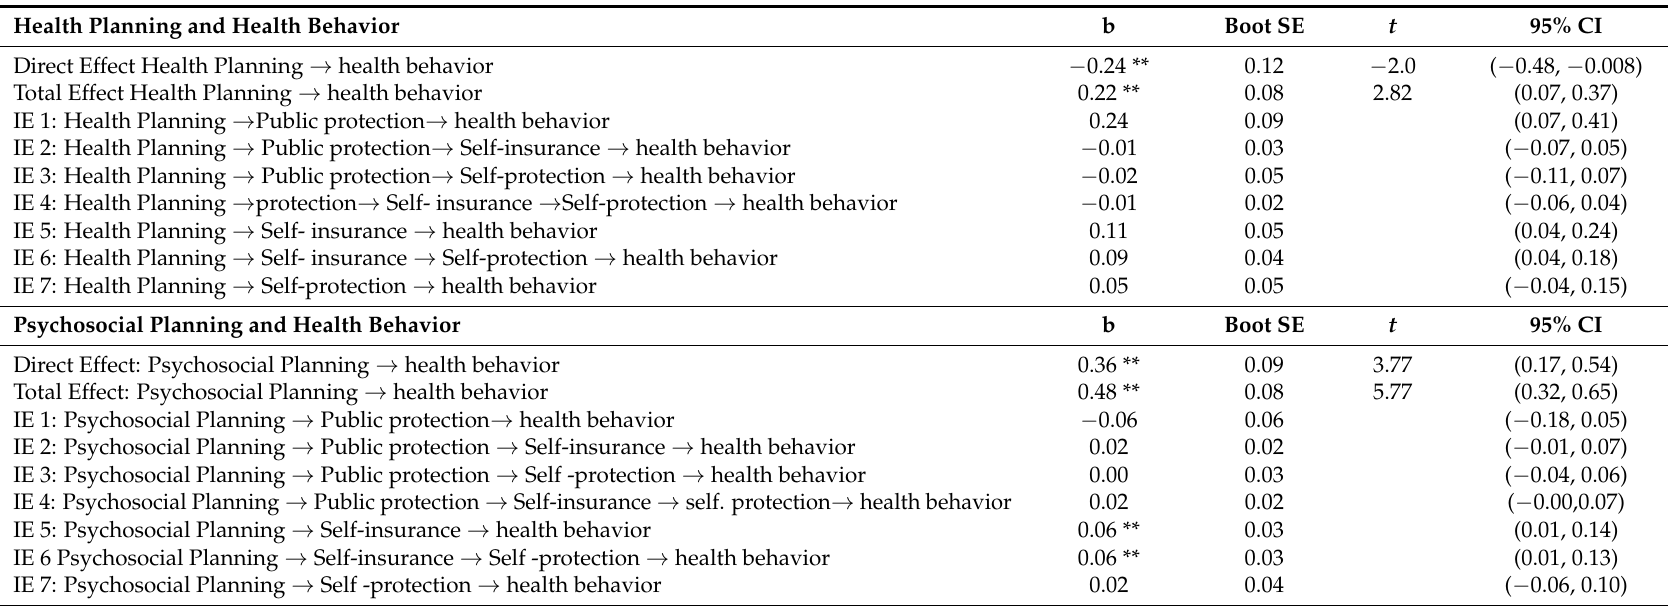
Table 3. Direct, total and indirect